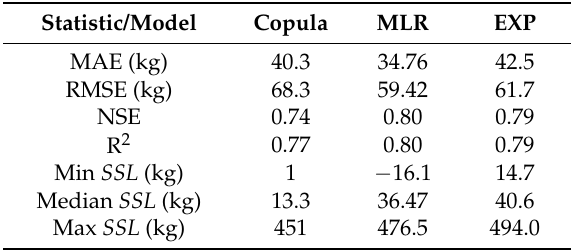
Figure 5. Distribution of possible SSL pseudo-values (solutions of Equation (7)), estimated SSL values in the copula space, 50% confidence intervals and measured SSL values for four events, which happened in different seasons for the Kuzlovec torrent. Table 3. Performance criteria results and summary statistics for the estimated SSL values for the Kuzlovec